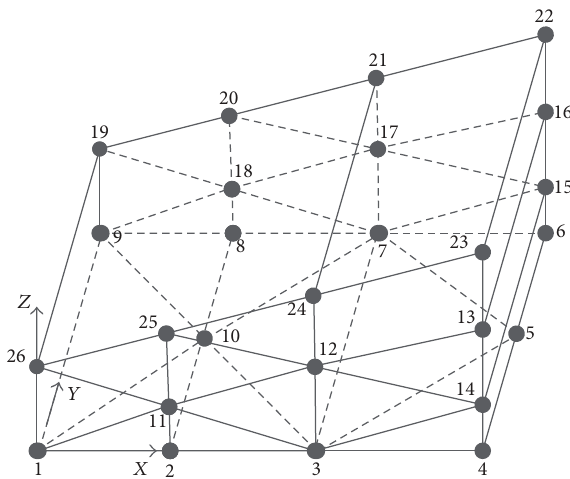
Figure 1: The schematic diagram of frame